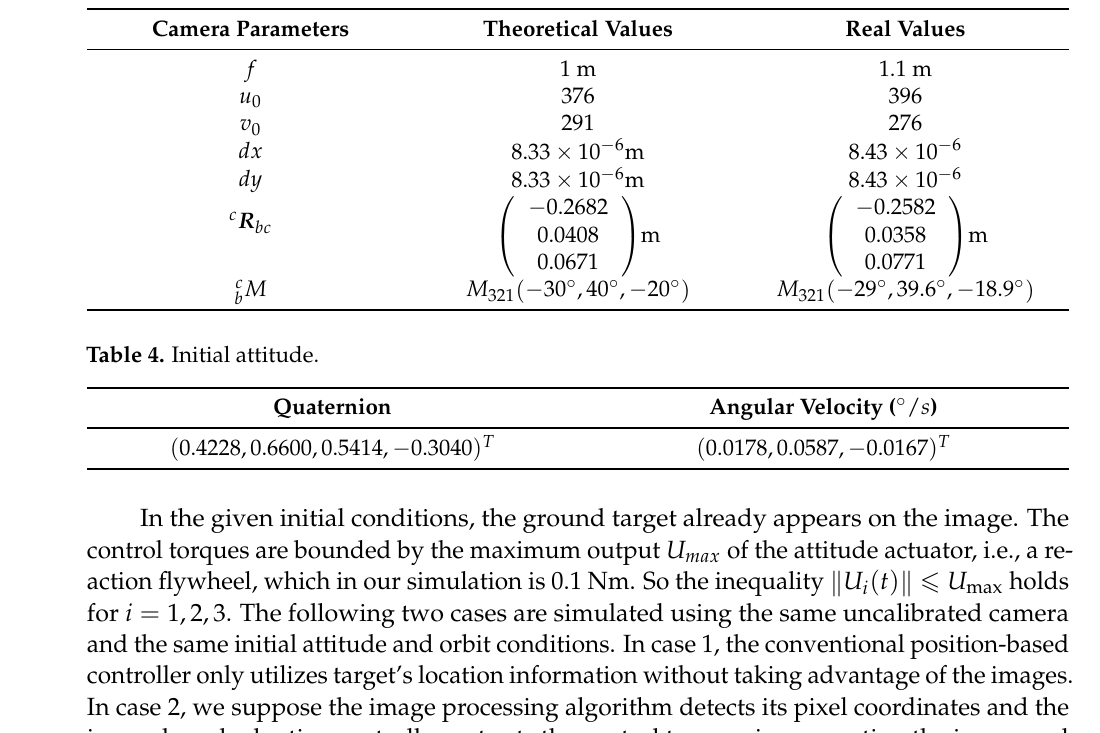
Table 3. Camera parameters.